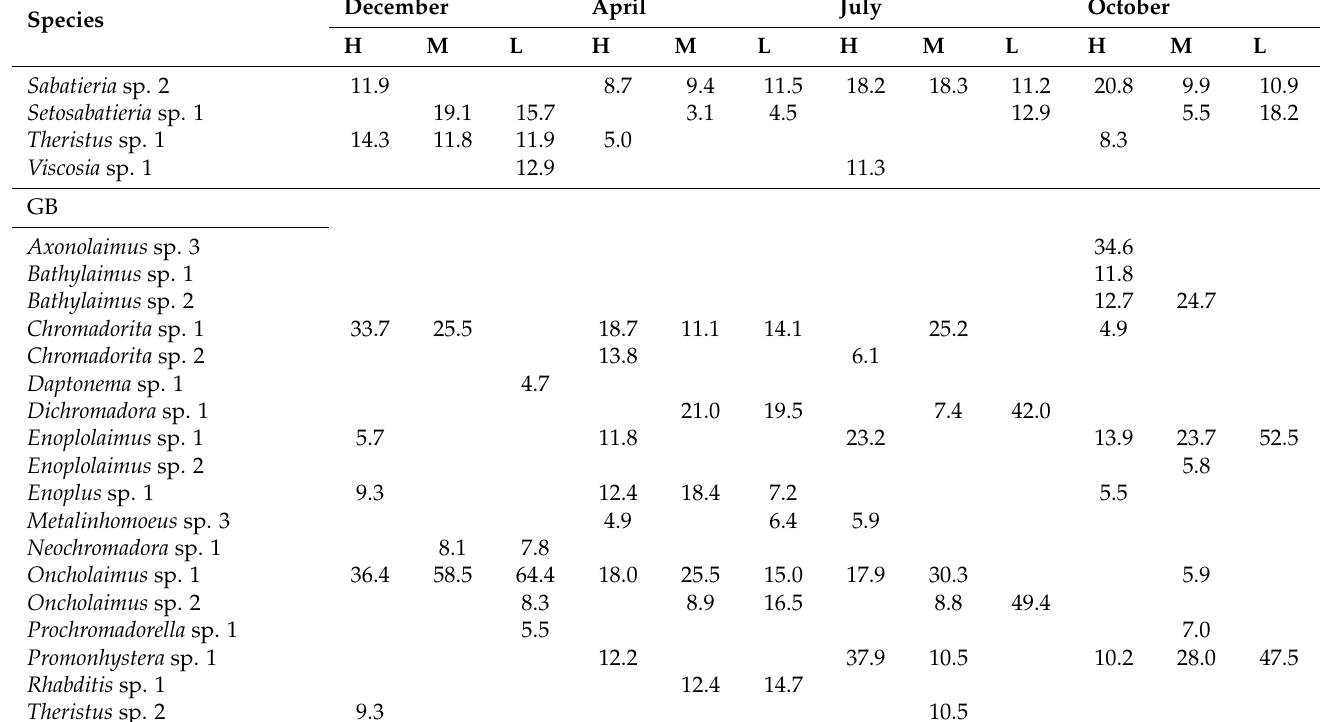
Figure 4. Non-metric multidimensional scaling (nMDS) of nematode community. Nematode spe- cies data were standardized and fourth root transformed. Vectors overlain on plot show correla- tions of families (>0.3) with nMDS axes, indicating important families that differentiate the com- munities. 3.3. Feeding Types of Nematode Community Non-selective deposit feeders (1B) dominated at XB sites (67.9 ± 12.8%), followed by epistrate feeders (2A, 28.8 ± 12.7%). The relative abundances of omnivores/predators (2B, 2.9 ± 5.5%) and selective deposit feeders (1A, 0.3 ± 0.3%) were low (Figure 5A). In contrast, the relative abundance of 2B nematodes was the highest (44.1 ± 16.5%) at GB sites. The mean relative abundance of non-selective deposit feeders was 27.2 ± 17.6%, and that of